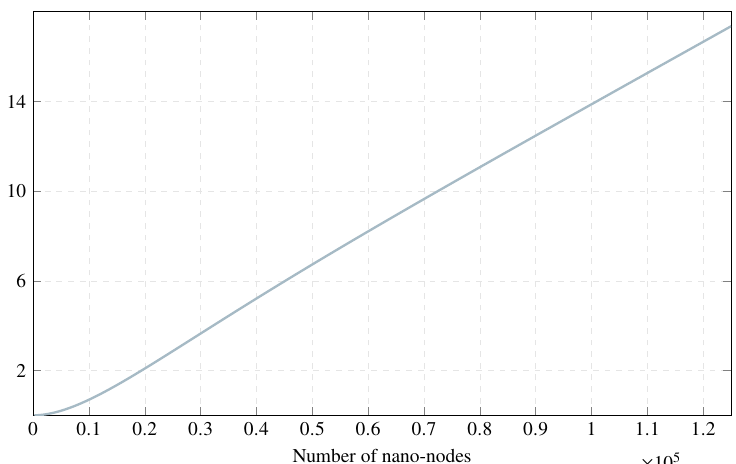
Figure A2. Average number of collisions for A = 2 × 10 − 3 m, f = 1Hz, σ = 2, and t f =